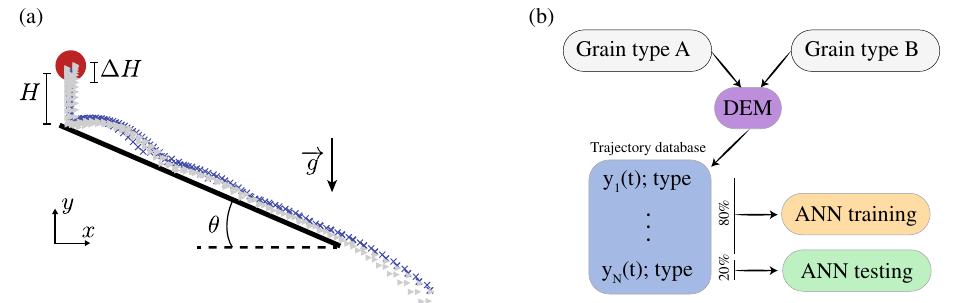
Figure 1. Grain classification based on behaviour. ( a ) Schematic representation of the simulated system where grains are dropped one at the time on an inclined plane. Grains free fall from a height selected at random with the range H ± (cid:31) H and bounce or roll onto a planar surface inclined at θ = 40 ◦ . Symbols represent two families of trajectories corresponding to grains of type A ( × ) and type B ( ◮ ) with different properties. ( b ) Flow chart depicting the method of analysis where an artificial neural network is trained and tested using simulated trajectories.